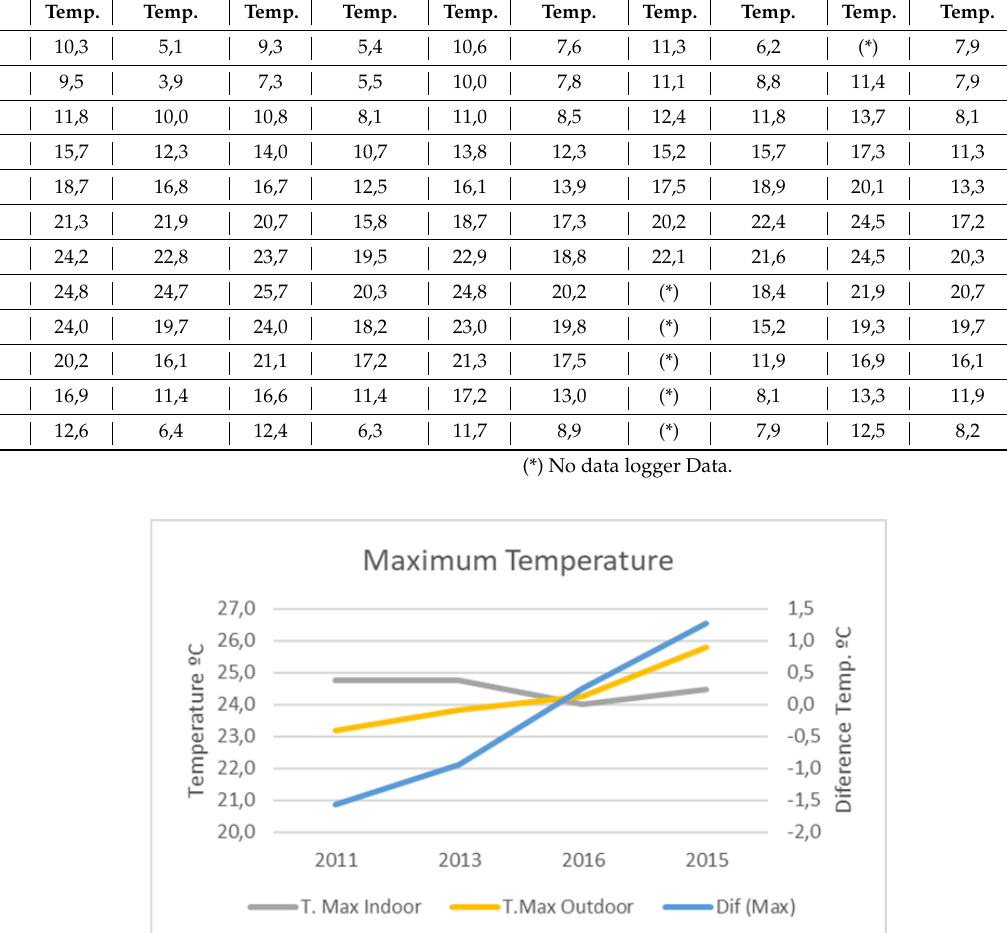
Figure 16. Maximum indoor and outdoor temperature and their difference in summer. During winter, the indoor temperature is always higher than the outdoor tempera- ture. The lower the outdoor temperature, the greater the difference between the indoor and outdoor temperature (Figure 17).